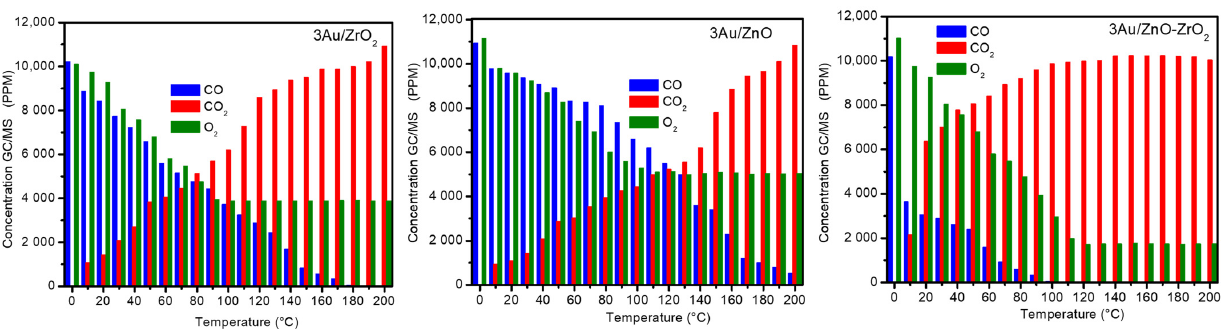
Figure 5. GC/MS profiles for the 3Au/ZrO 2 , 3Au/ZnO , and 3Au/5ZnO − ZrO 2 catalysts in the CO oxi- dation from RT to 200 °C.